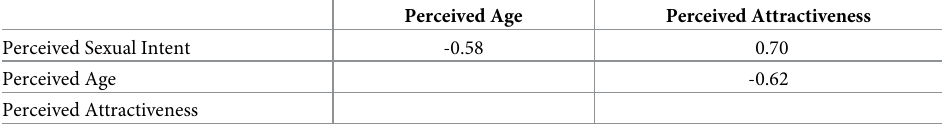
Table 2. Correlations between three target women predictor variables perceived sexual intent, perceived age and perceived